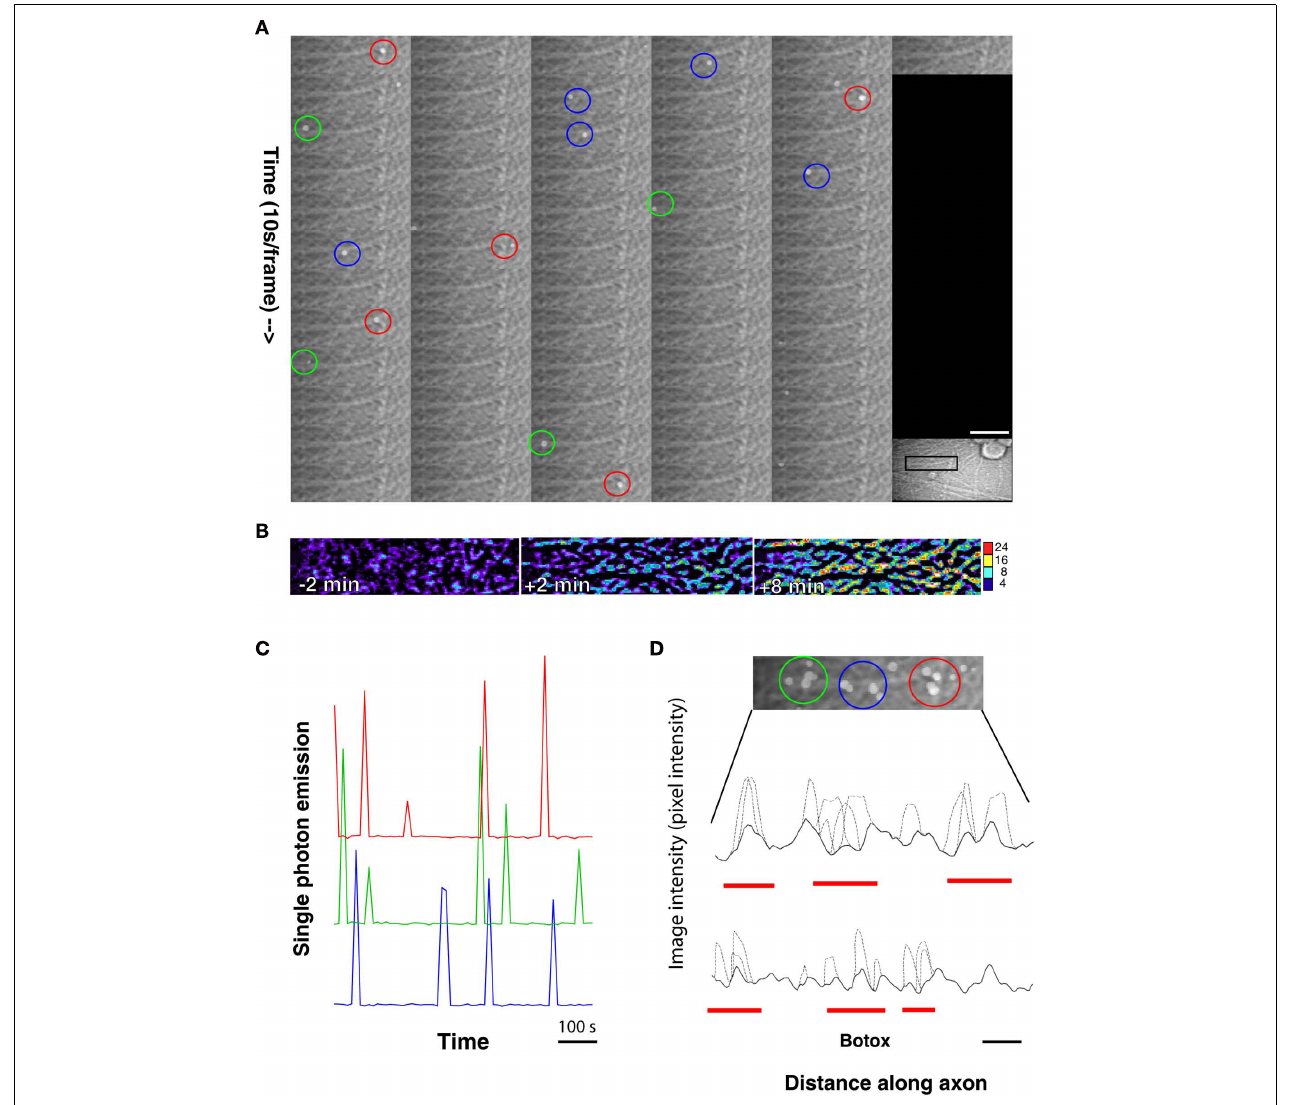
over time in colors corresponding to the three regions of interest. Note the repeated release of photons from localized regions of the axon. (D) All 61 images shown in the montage in (A) have been combined to analyze the spatial distribution of single-photon events. Note that the photon emissions over time occur in an uneven distribution along the axon suggesting localized areas of ATP release from axons. A line scan of image intensity along the axon is plotted to that show photon emissions (dotted lines) along the axon are clustered into “hot spots” (red lines).The solid line is the transmitted light intensity profile of the axon. A similar line scan from another experiment shows similar action potential-induced ATP release from axons in the presence of botulinum toxin, which blocks vesicular release. Scale bar (black) = 15 μ m (upper line scan) and 9 μ m (lower line